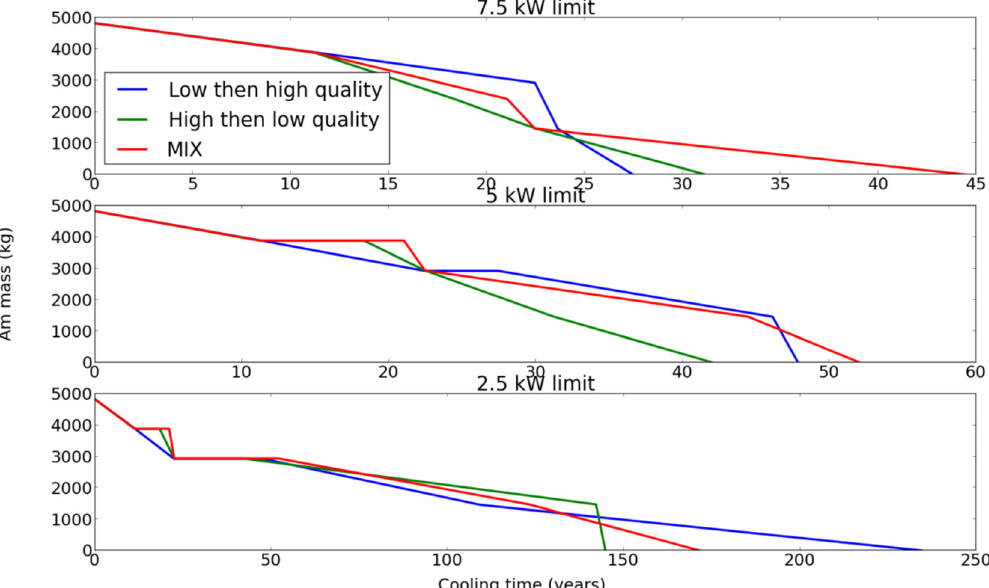
Fig 4. Evolution of the americium in the fuel cycle depending on the strategy considered and on the reprocessing limit for coupled scenarios with various Pu qualities in SFR.